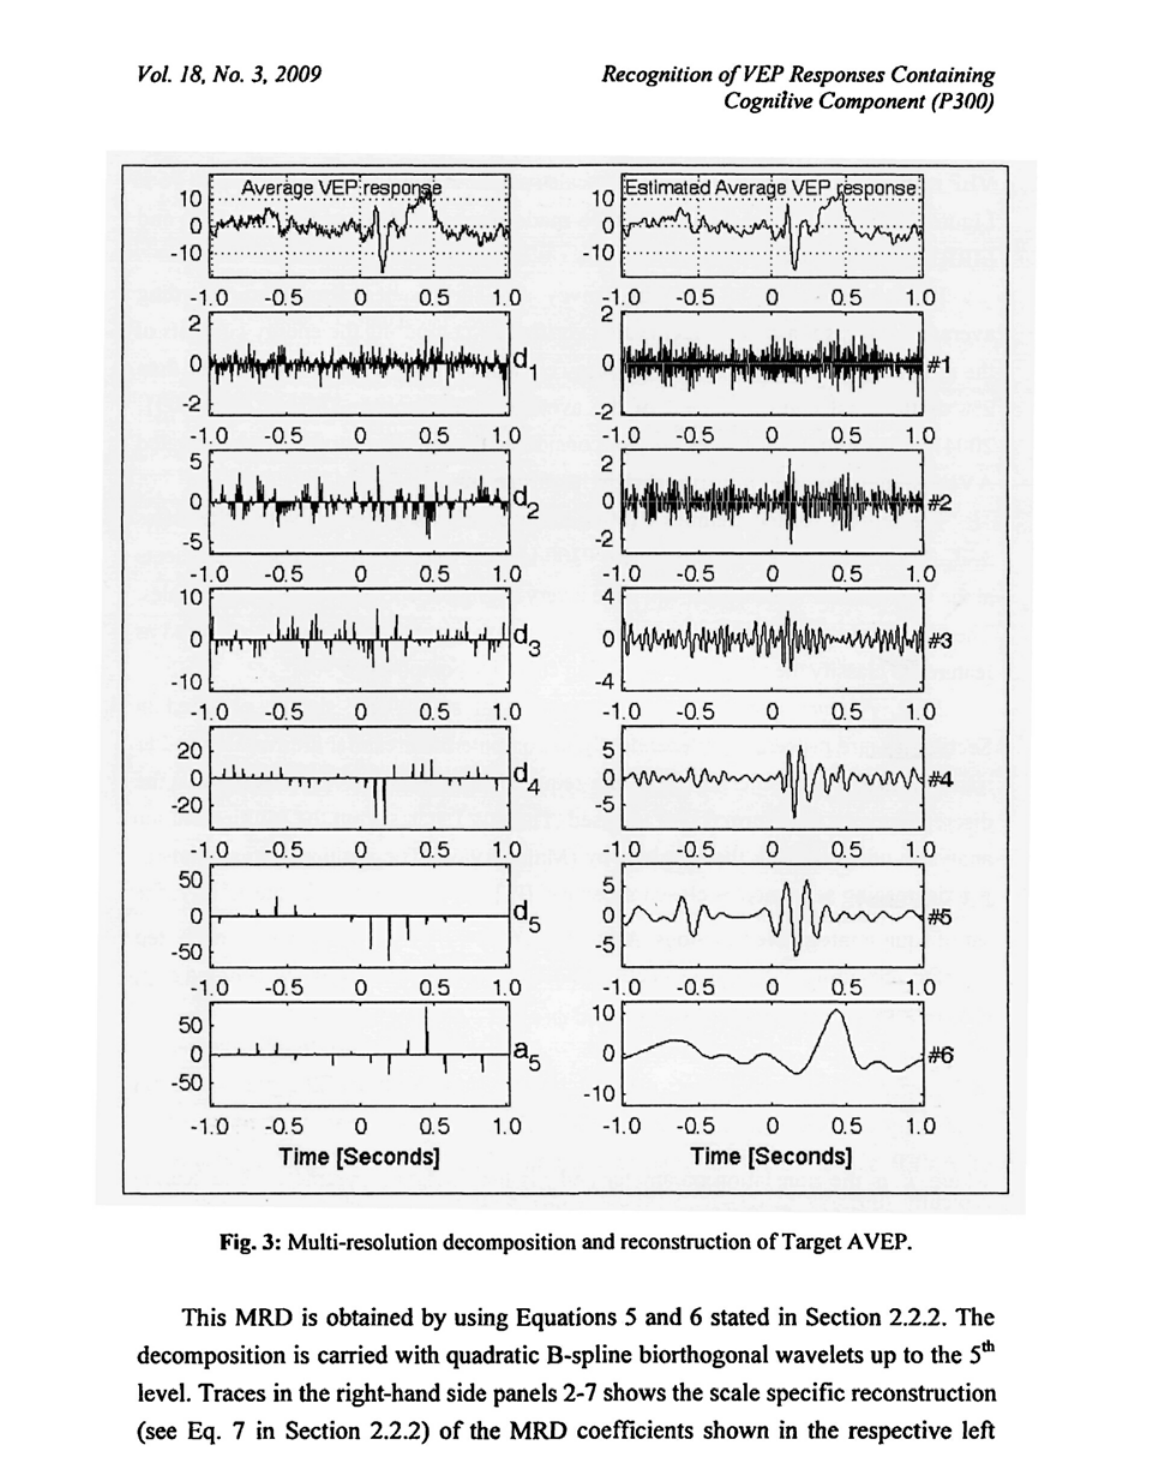
Fig. 3: Multi-resolution decomposition and reconstruction of Target AVEP. This MRD is obtained by using Equations 5 and 6 stated in Section 2.2.2. The decomposition is carried with quadratic B-spline biorthogonal wavelets up to the